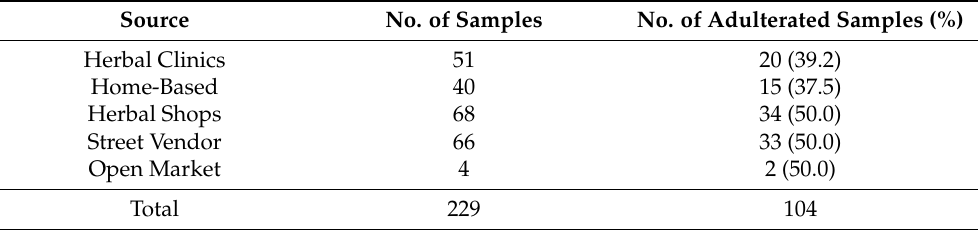
Table 3. Adulteration of herbal products according to the supplying sources.